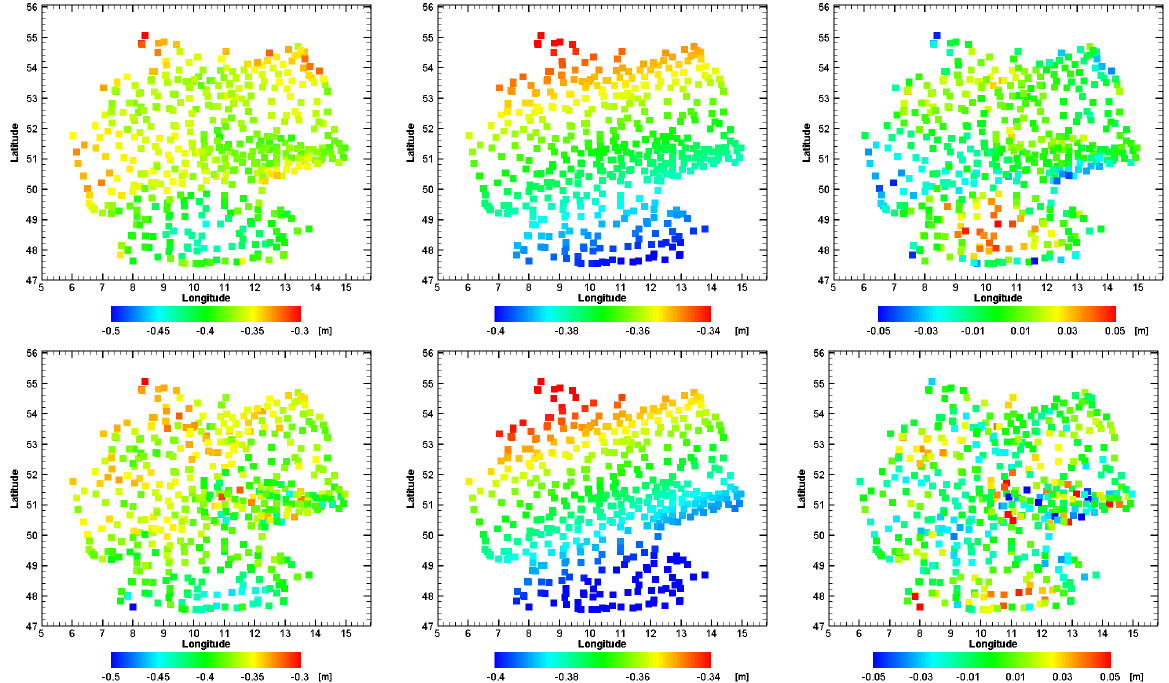
Fig. 3. Differences of EGM2008 and PGM2017 height anomalies to GNSS-levelling height anomalies in Germany (data set G07) for full model resolution (degree 2190). All units in [m]. Top row: EGM2008 model; Bottom row: PGM2017 model; Left column: Raw differences without applying planar correction surface; Middle column: Correction surface at GNSS-levelling points; Right column: Differences after applying the correction.